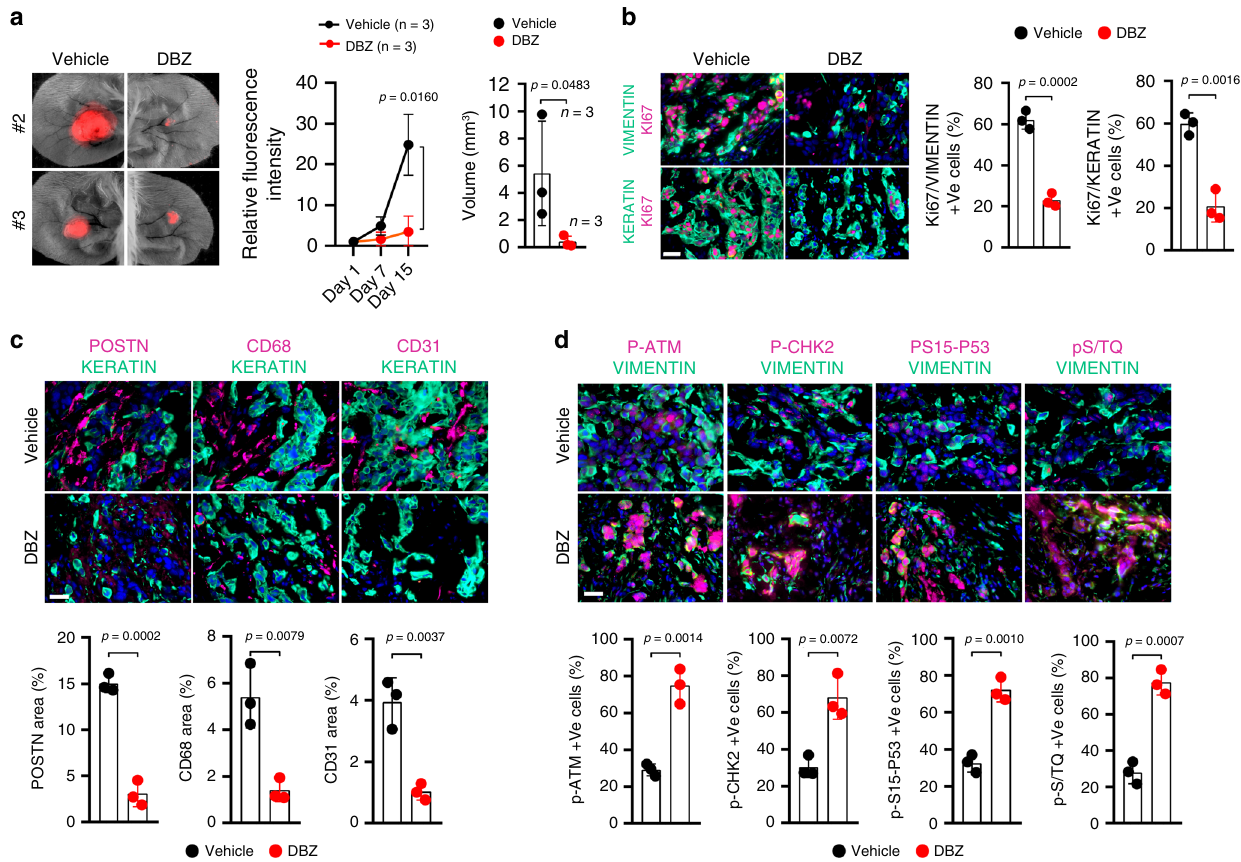
Fig. 10 Topical treatment with NOTCH1 inhibitors impairs cancer/stromal cell expansion in vivo. a DsRed2-expressing SCC13 cells admixed with CAFs (CAF13) were injected into ears of NOD/SCID mice, followed by topical treatment with DBZ (1 mM) or Ethanol vehicle alone daily for 1 week starting 24 h after injection. Mice were killed 15 days after injection. Shown are images of two ear pairs 15 days after injection, quanti fi cation of red fl uorescence signal (normalized to day 1 after injection) corresponding to SCC13 cell expansion and tumor volumes ( V = (length × width 2 ) × 0.5). Statistical analysis of fl uorescence intensity values over time course of the experiment was calculated by Two-way ANOVA, * p < 0.05. Tumor volume values are indicated as dots with mean ± s.d. two-tailed unpaired t -test, * p < 0.05. n (CTR ear lesion) = 3, n (DBZ ear lesion) = 3. b – d Representative images and quanti fi cation of immuno fl uorescence analysis of ear lesions with antibodies against the indicated proteins as in Fig. 9b – d. Scale bar, 50 μ m. Values for each lesion